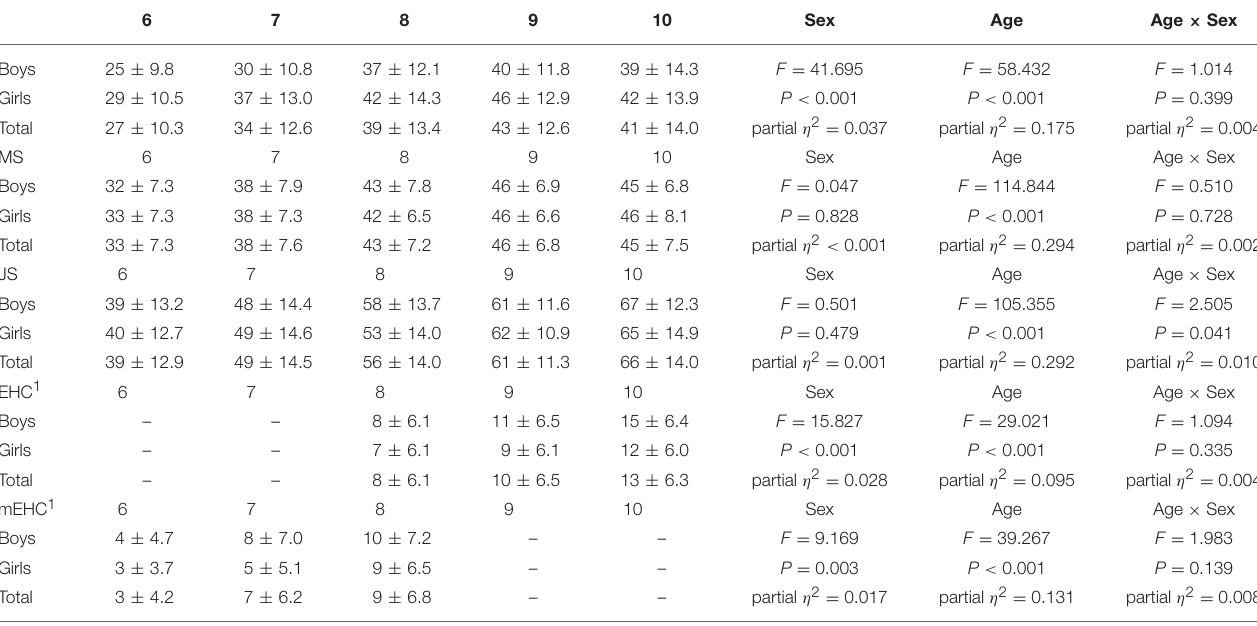
TABLE 2 | Raw scores (mean ± SD) of the FMS assessment test items including univariate GLM analysis for effects of sex and age of 6- ( n = 192), 7- ( n = 265), 8- ( n = 266), 9- ( n = 277), and 10- ( n = 121) year olds.